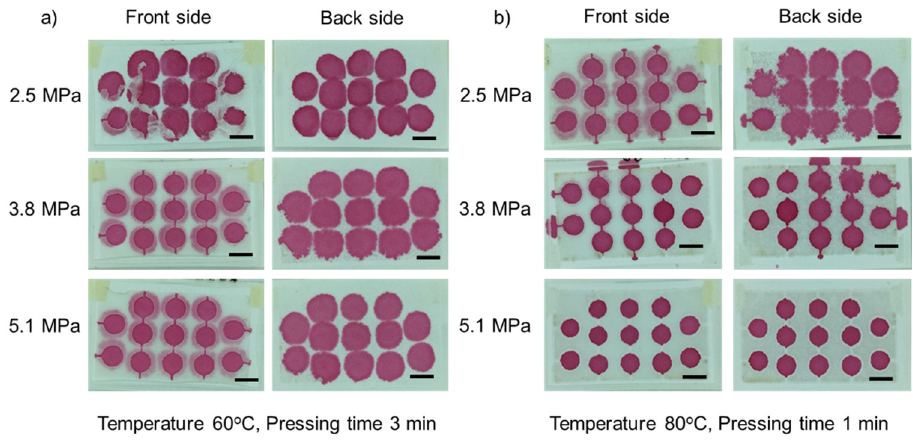
Figure 4. Effect of pressure: ( a ) under a temperature of 60 °C and 3 min of pressing time; ( b ) under a temperature of 80 °C and 3 min of pressing time. The pressure was varied from 2.5–5.1 MPa in the row (left column shows the front side, right column shows the back side). Scale bar is 5 mm.